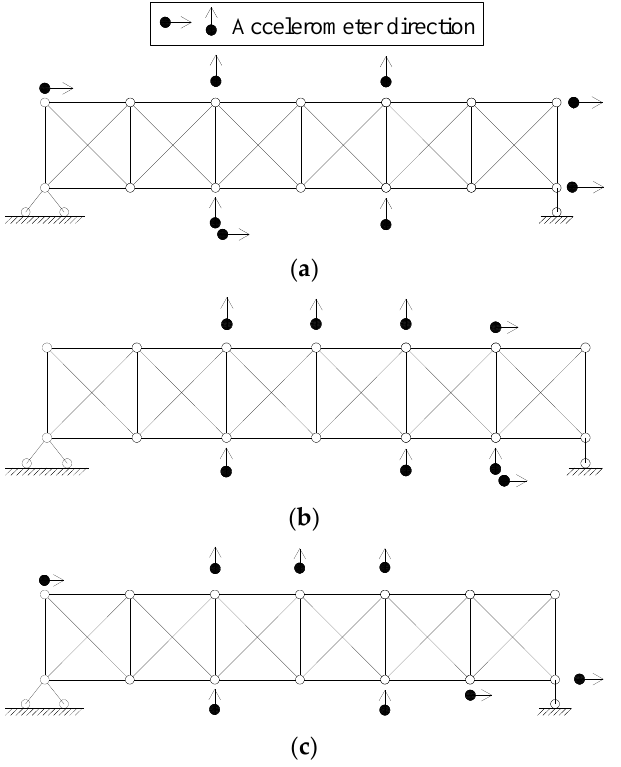
Figure 9. Sensor placement proposals from Pareto front of EI and MSMKE: ( a ) solution ‘D’; ( b ) solution ‘B’; ( c ) solution ‘C’.